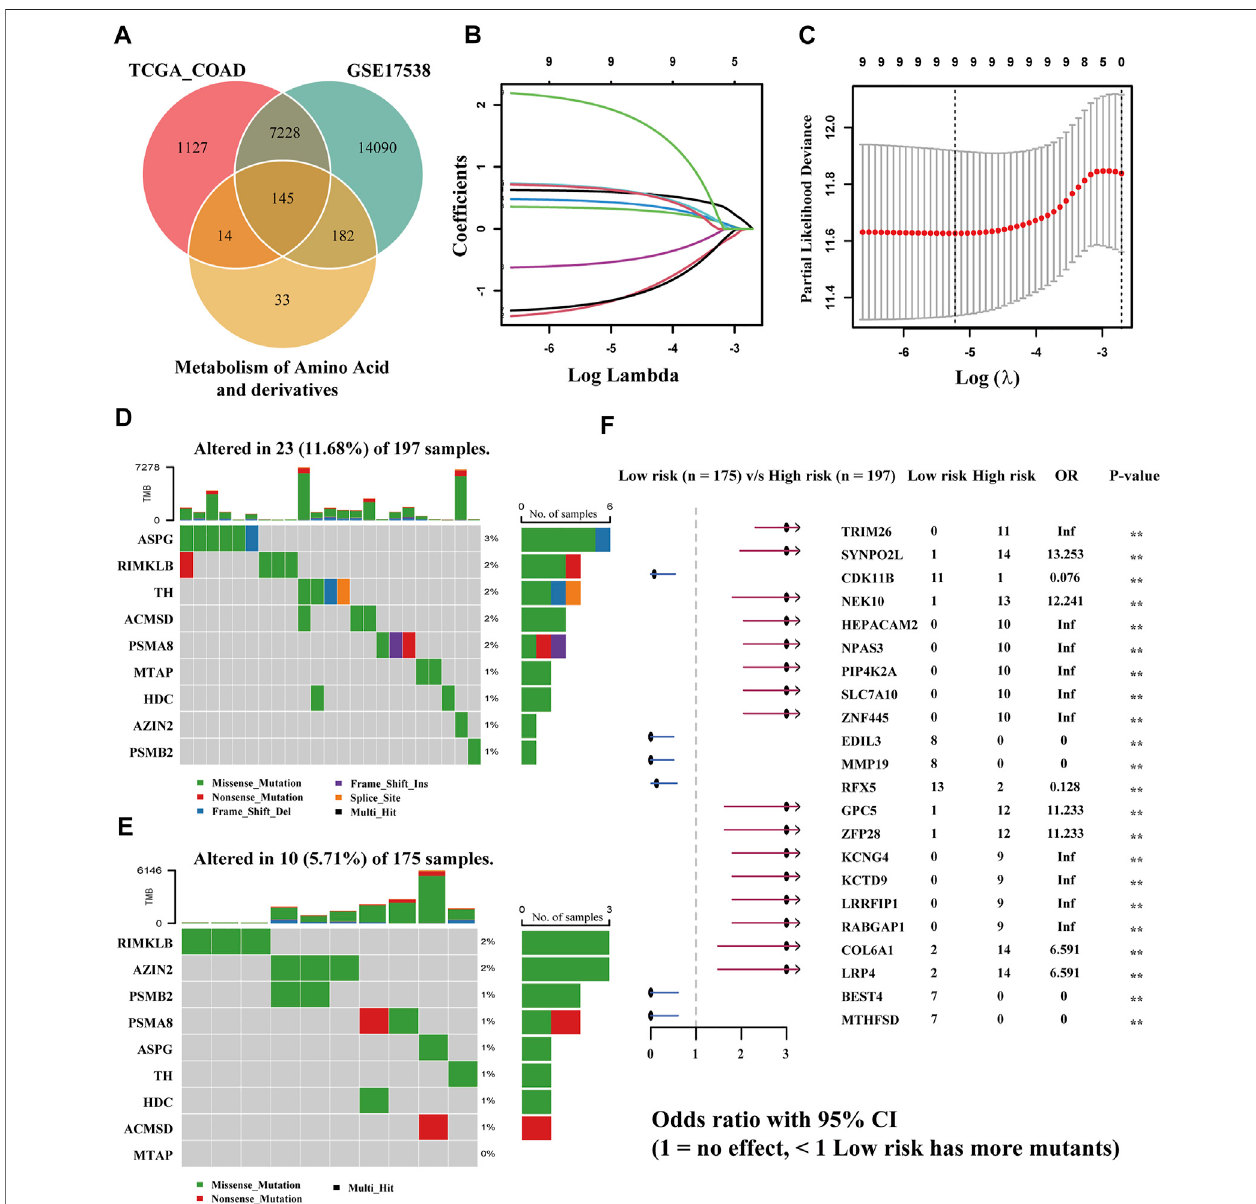
FIGURE2| Establishment ofariskmodelaccordingtoaminoacidmetabolism-relatedgenesinTCGA-COAD andcorrespondingTMBanalysis. (A) Intersectionof DEGs of TCGA-COAD and GSE17538 and amino acid metabolism-related genes. (B,C) LASSO analysis to obtain the nine gene signatures and corresponding coef fi cients to build the risk model. (D,E) TMB of high- and low-risk groups. (F) Comparison of the signi fi cant mutation genes between the two